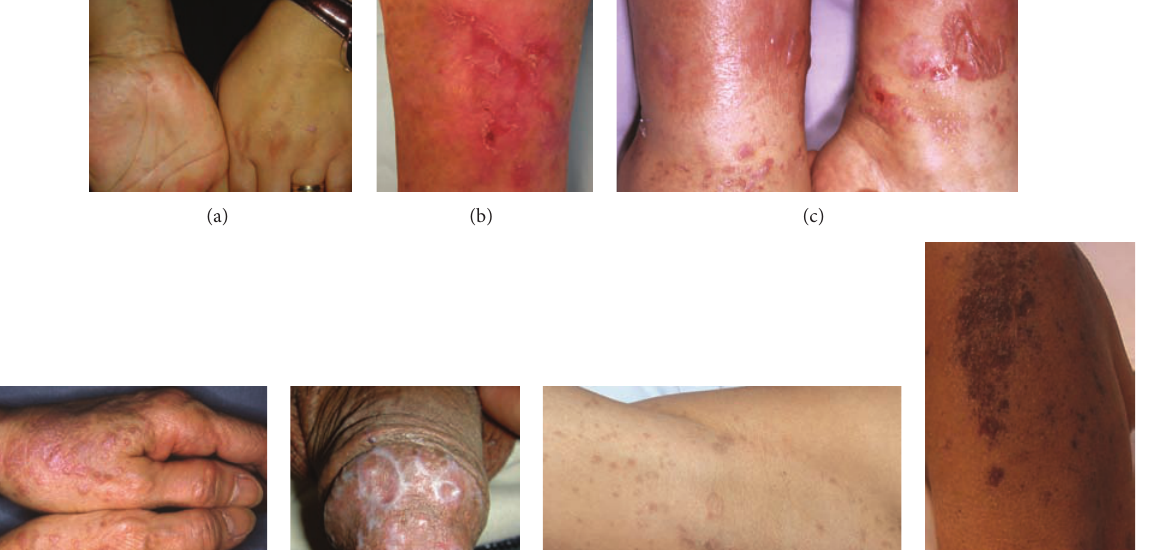
by the triad of follicular-based spinous Papules on the body, scalp, or both, patchy cicatricial alopecia of the scalp, and noncicatricial alopecia of the axilla and pubic region. It is preferentially more common in females